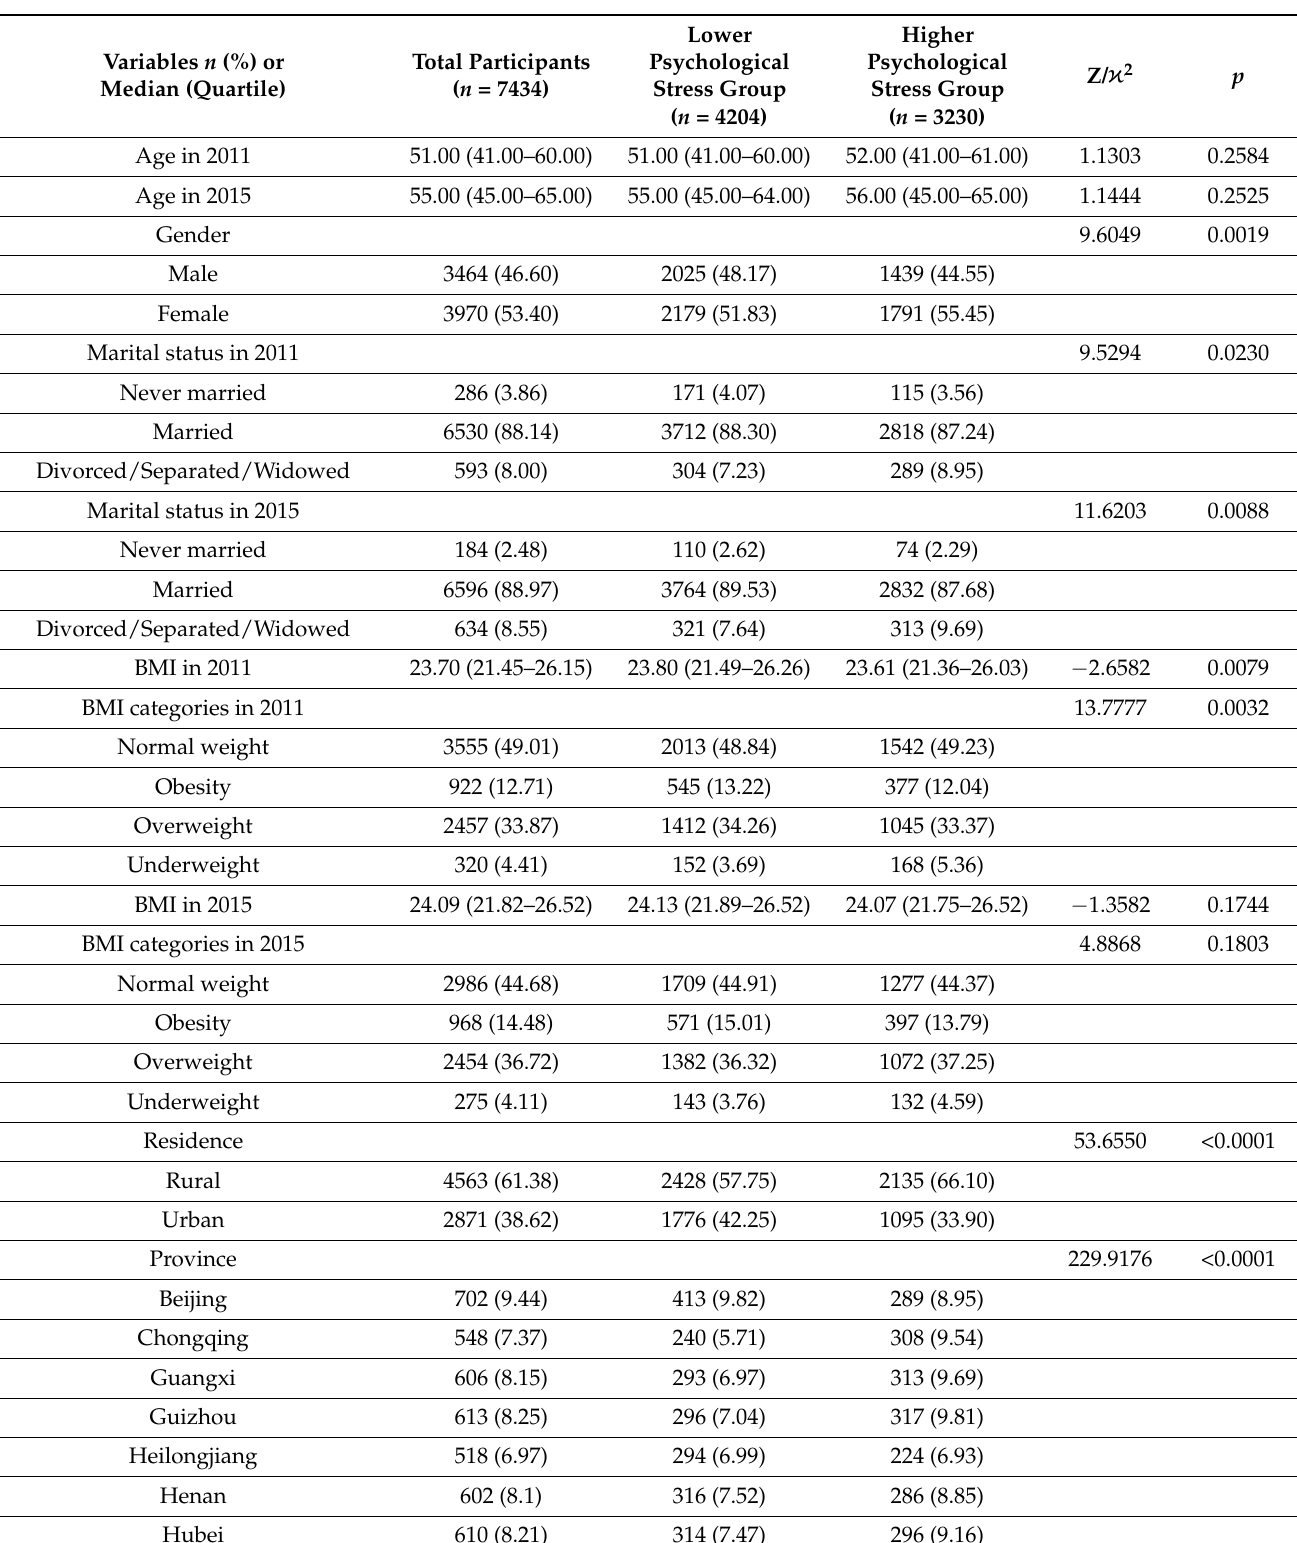
Table 1. Descriptive statistics of participants.